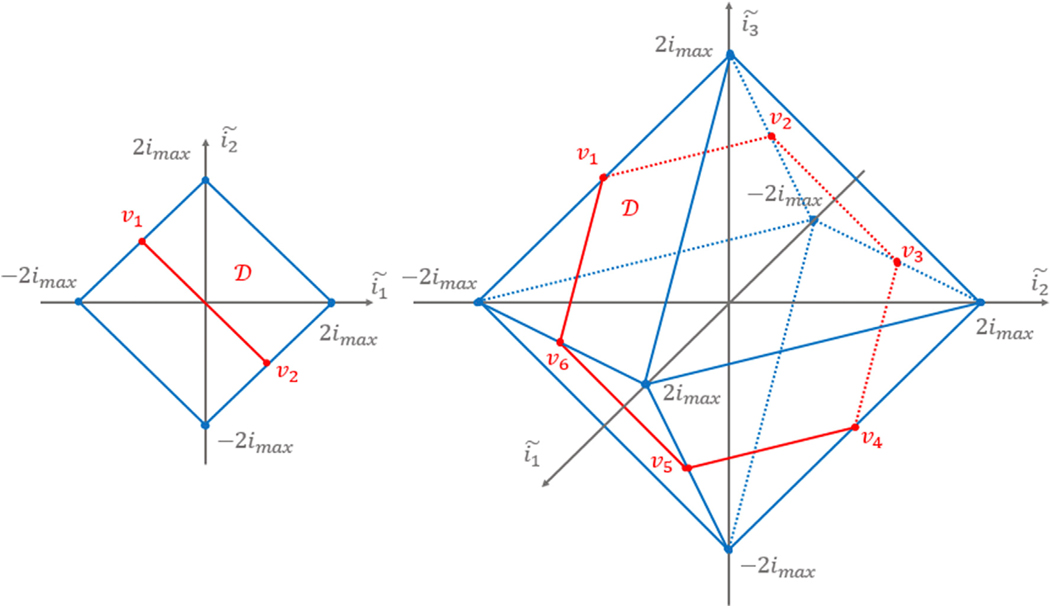
Feasible domains D for the 2D (left) and 3D (right) cases, assuming two and three electrodes respectively. All vertices correspond to only two active electrodes. The 2D case is trivial, with two electrodes, there are only two possible injection patterns: (imax,−imax)and(−imax,imax). For the 3D case there are six vertices, i.e., six possible solutions.